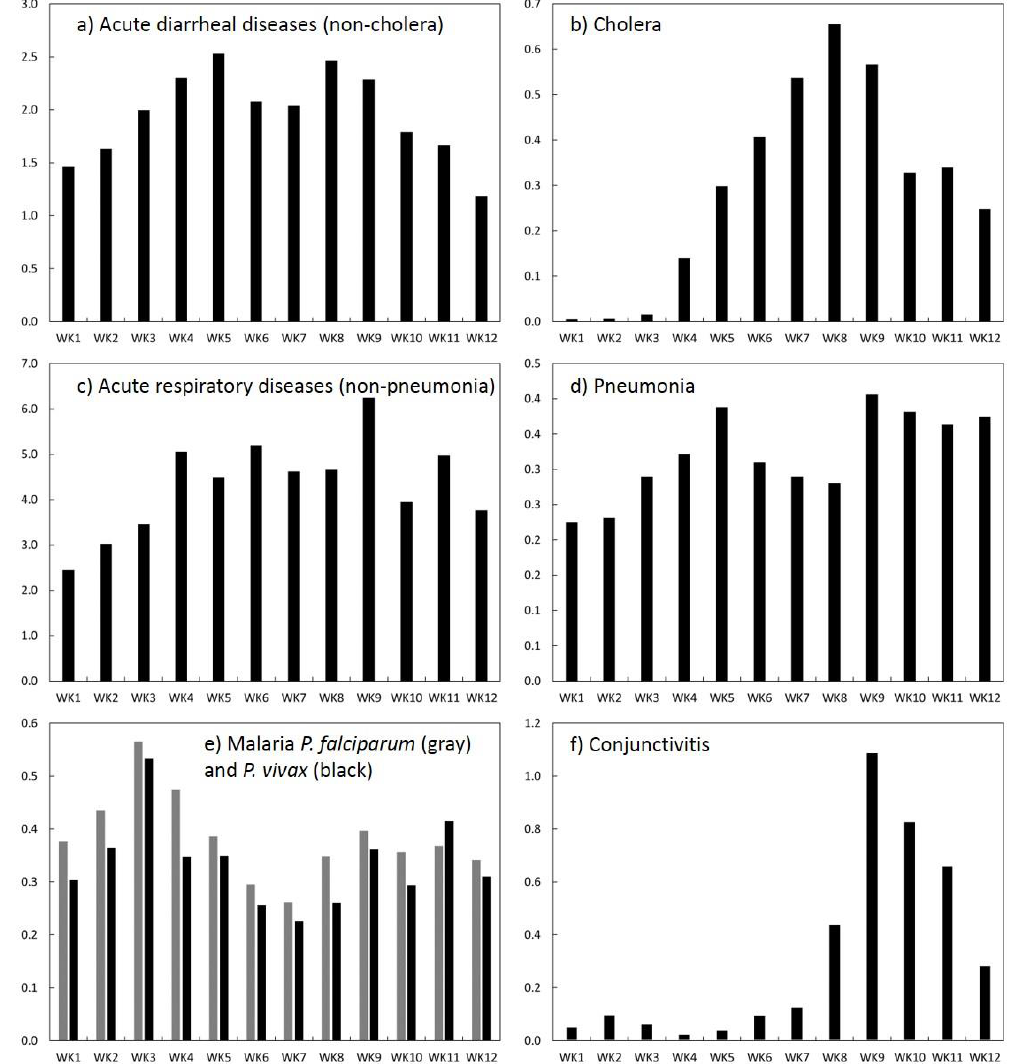
Figure 3. Weekly time plots of disease incidence (per 1000 population) for the study area (all districts): ( a ) EDAS (acute diarrheal diseases — non-cholera); ( b ) cholera; ( c ) IRAS (acute respiratory diseases — non-pneumonia); ( d ) pneumonia; ( e ) malaria P. falciparum and malaria P. vivax ; ( f ) conjunctivitis.